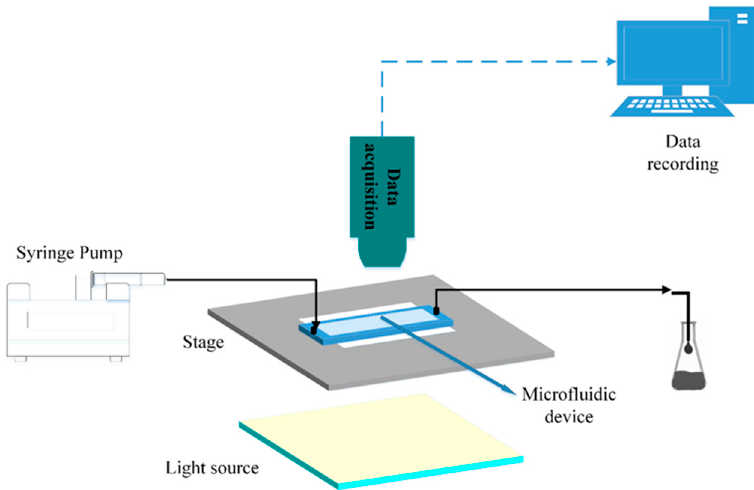
Figure 1. Microfluidic displacement experimental setup.